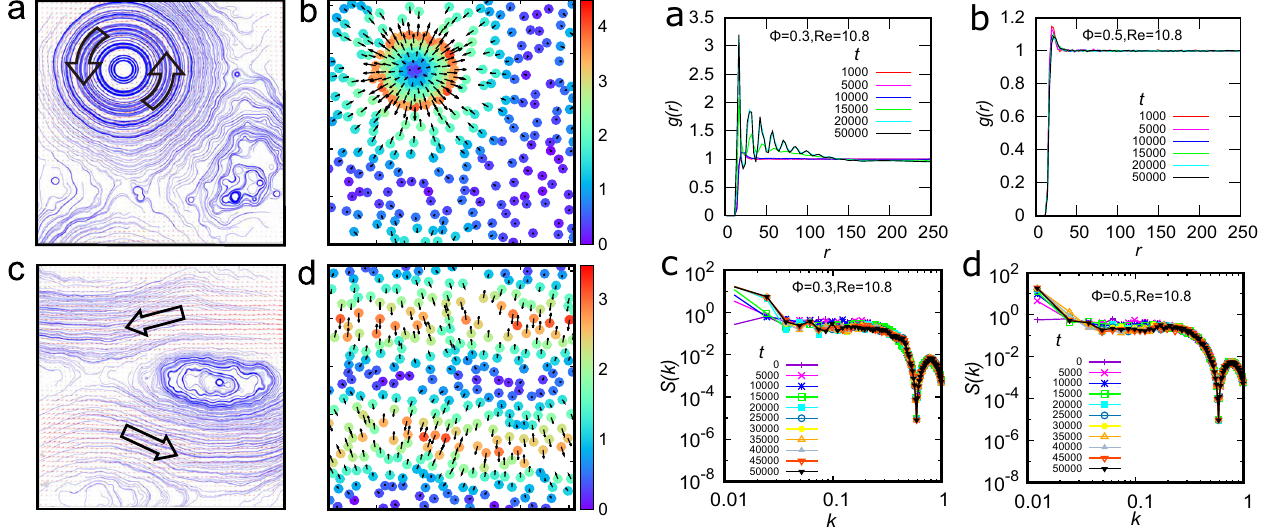
Fig. 4 Temporal evolution of the radial distribution function g ( r ) and the structure factor S ( k ). Here we distinguish the rotational direction of disk rotation for S ( k ), whereas we do not distinguish it for g ( r ). a , b The time t -dependences of g ( r ) for an off-symmetric composition (OSM) ( Φ = 0.3, Re = 10.8) and a symmetric composition (SM) ( Φ = 0.5, Re = 10.8), respectively. c , d The t -dependences of S ( k ) for OSM ( Φ = 0.3, Re = 10.8) and SM ( Φ = 0.5, Re = 10.8), respectively. The peculiar shape of S ( k ) around k ~ 1 re fl ects the form factor of a